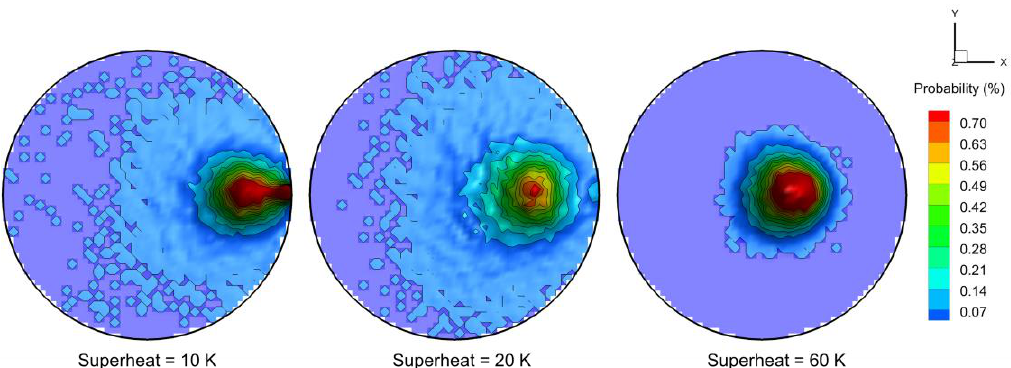
Figure 12. E ff ect of superheat on the melting position of aluminum Figure 12. Effect of superheat on the melting position of aluminum particles. Figure 12. Effect of superheat on the melting position of aluminum particles.